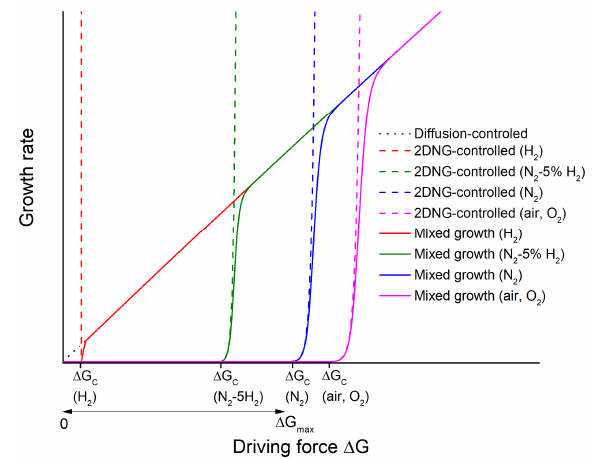
Figure 11. Schematic of growth rate vs. driving force for samples sintered in different atmospheres (2DNG = 2D nucleation-controlled growth).